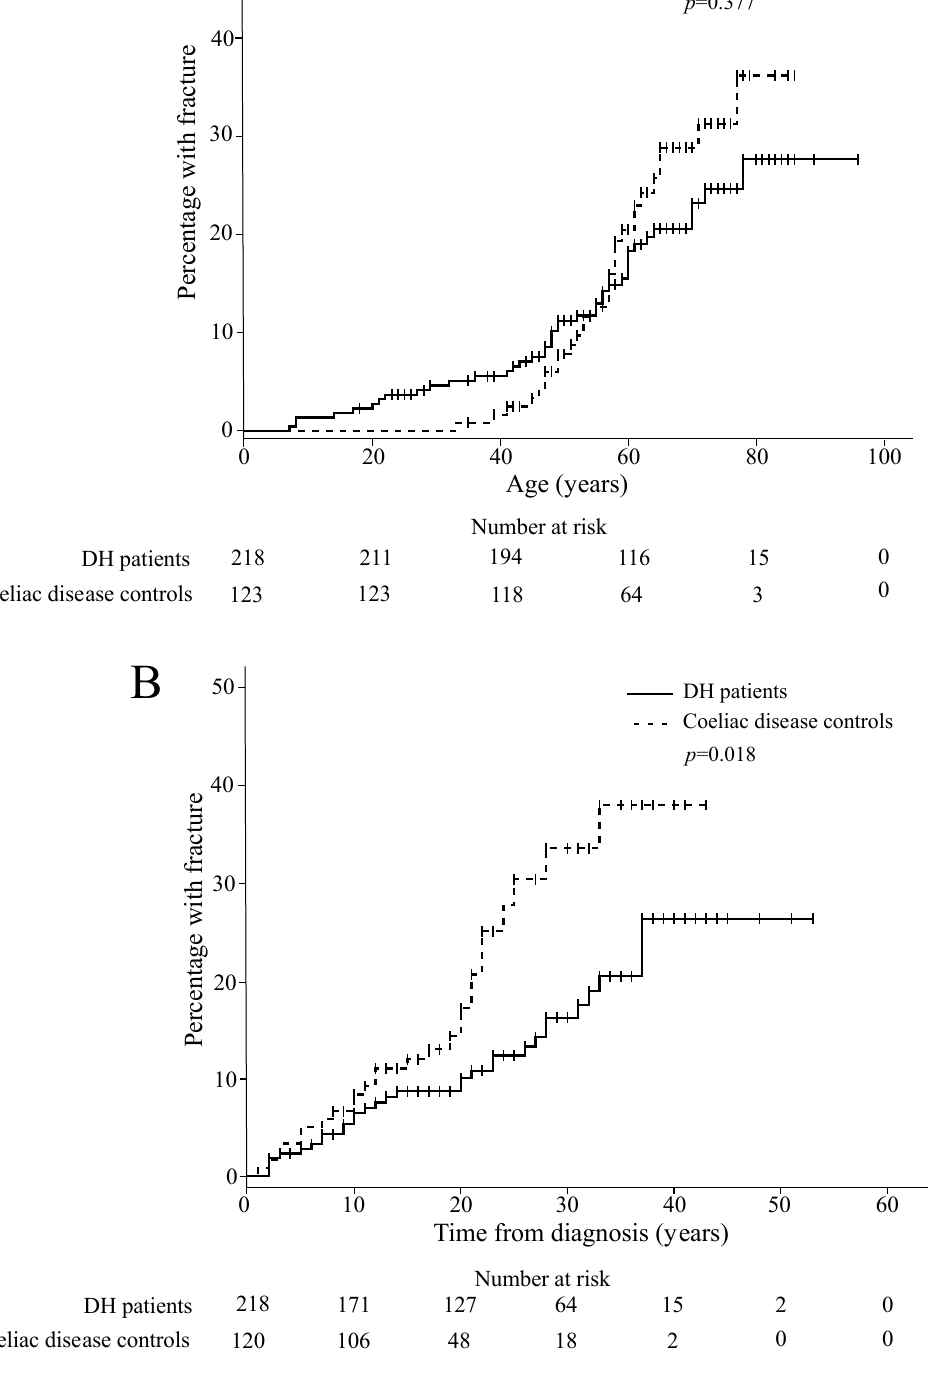
Figure 1. Kaplan–Meier cumulative incidence of the first fracture ( A ) and for first fracture after diagnosis ( B ) for the dermatitis herpetiformis (DH) patients and the coeliac disease controls.